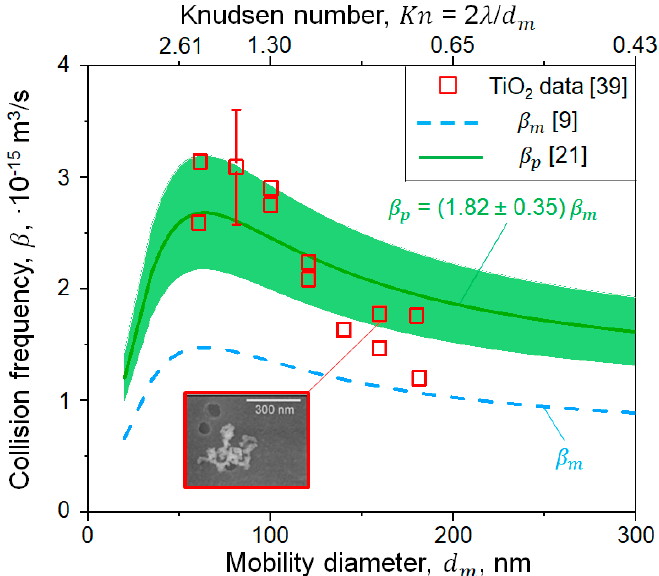
Figure 2. Evolution of collision frequency, β , as a function of agglomerate mobility diameter, d m (bottom abscissa), or Knudsen number, Kn (top abscissa), measured for flame-made TiO 2 agglomer- ates (squares, inset) [39] compared to β m (Equation (4), broken line) and β p (Equation (9), solid line and